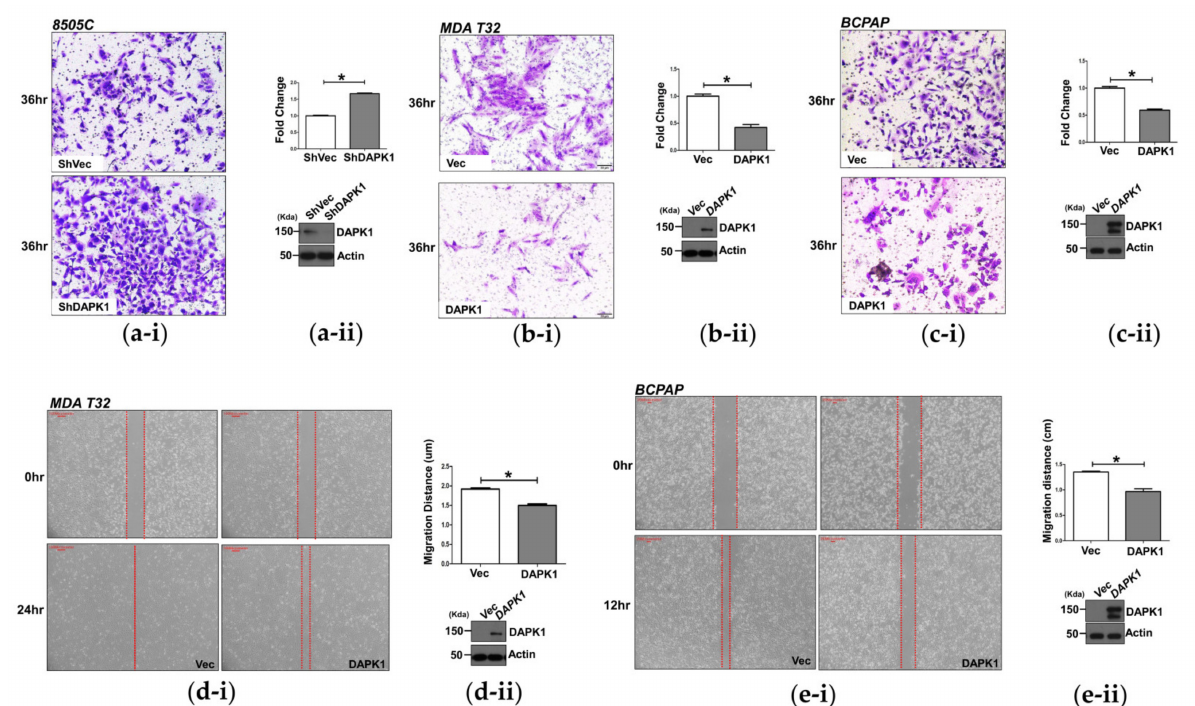
Figure 2. DAPK1 is associated with the migration and invasion ability of 8505C, MDA-T32, and BCPAP cancer cells. ( a-i ) Transwell assays were performed in the 8505C cells after stable knockdown of DAPK1 . A representative image was acquired 36 h after the initial seeding (pore size 0.8 µ m). The image was acquired at a magnification of 1000 × ; scale bar represents 50 µ m. ( a-ii ) Graph of the quantified results of ( a-i ). The sh DAPK1 -8505C cells demonstrated significant migration compared with the shVector -8505C cells. The expression level of sh DAPK1 -8505C cells was confirmed by Western blot. ( b-i ) Transwell assays were performed in the MDA-T32 after stable overexpression of DAPK1 . A representative image was obtained from an image dyed 36 h after the initial seeding (pore size 0.4 µ m). The image was acquired at a magnification of 100 × ; scale bar represents 50 µ m. ( b-ii ) Graph of the quantified results of ( b-i ). The DAPK1 -overexpressed MDA-T32 cells showed a significant decrease in invasion compared with the control. The expression level of DAPK1 -overexpressed MDA-T32 cells was confirmed by Western blot. ( c-i ) Transwell assays were performed in the BCPAP after stable overexpression of DAPK1 . A representative image was acquired 36 h after the initial seeding (pore size 0.4 µ m). The image was acquired at a magnification of 100 × ; scale bar represents 50 µ m. ( c-ii ) Graph of the quantified results of ( c-i ). The DAPK1 -overexpressed BCPAP cells also showed a significant decrease in invasion compared with the control. The expression level of DAPK1 -overexpressed BCPAP cells was confirmed by Western blot. ( d-i ) Wound-healing assays were performed in the MDA-T32 cells after stable overexpression of DAPK1 . The representative image was acquired at the time of initial scratching and 24 h after. ( d-ii ) Quantification of the results of ( d-i ). The migration distance was calculated by comparing the gap distance of three different points at the initial and final time. The expression level of DAPK1 -overexpressed MDA-T32 cells was confirmed by Western blot. ( e-i ) Wound-healing assays were performed in the BCPAP cells after stable overexpression of DAPK1 . The representative image was acquired at the time of initial scratching and 12 h after the initial scratching. ( e-ii ) Quantification of the results of ( e-i ). The migration distance was calculated by comparing the gap distance of three different points at the initial and last time. The expression level of DAPK1 -overexpressed BCPAP cells was confirmed by Western blot. Asterisks ( p < 0.05 (*)) indicate significant differences in the statistical analyses. Each data point represents the mean ± standard error of three independent